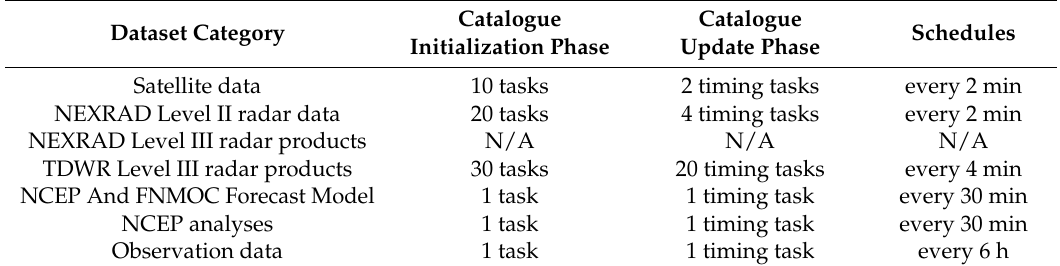
Table 6. Tasks and schedules for monitoring Unidata IDD.